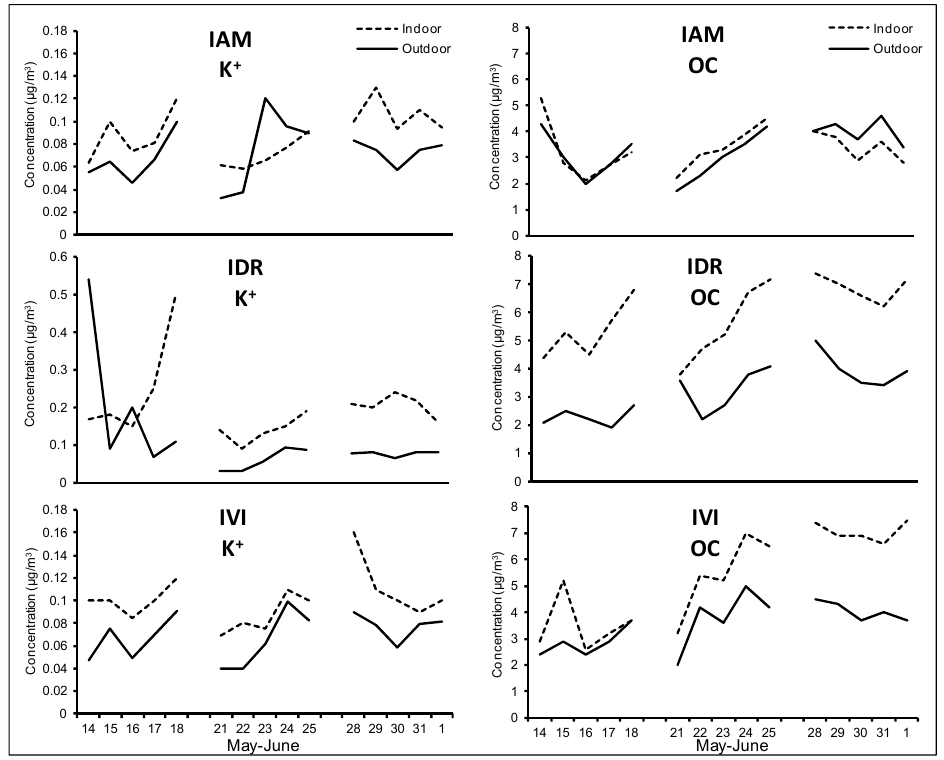
Figure A6. K + and OC daily concentrations measured outdoor (solid lines) and indoor (dotted lines) at the three schools during the spring/summer